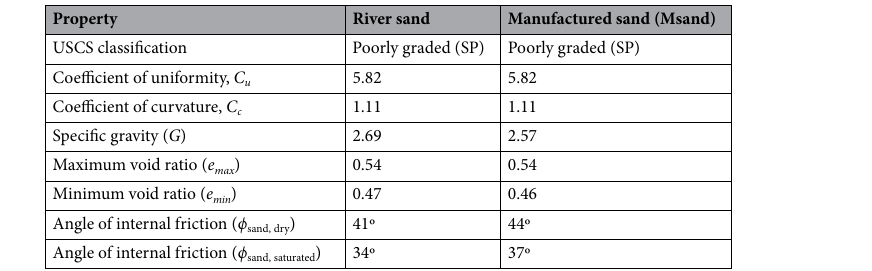
Table 1. Physical properties of sand.